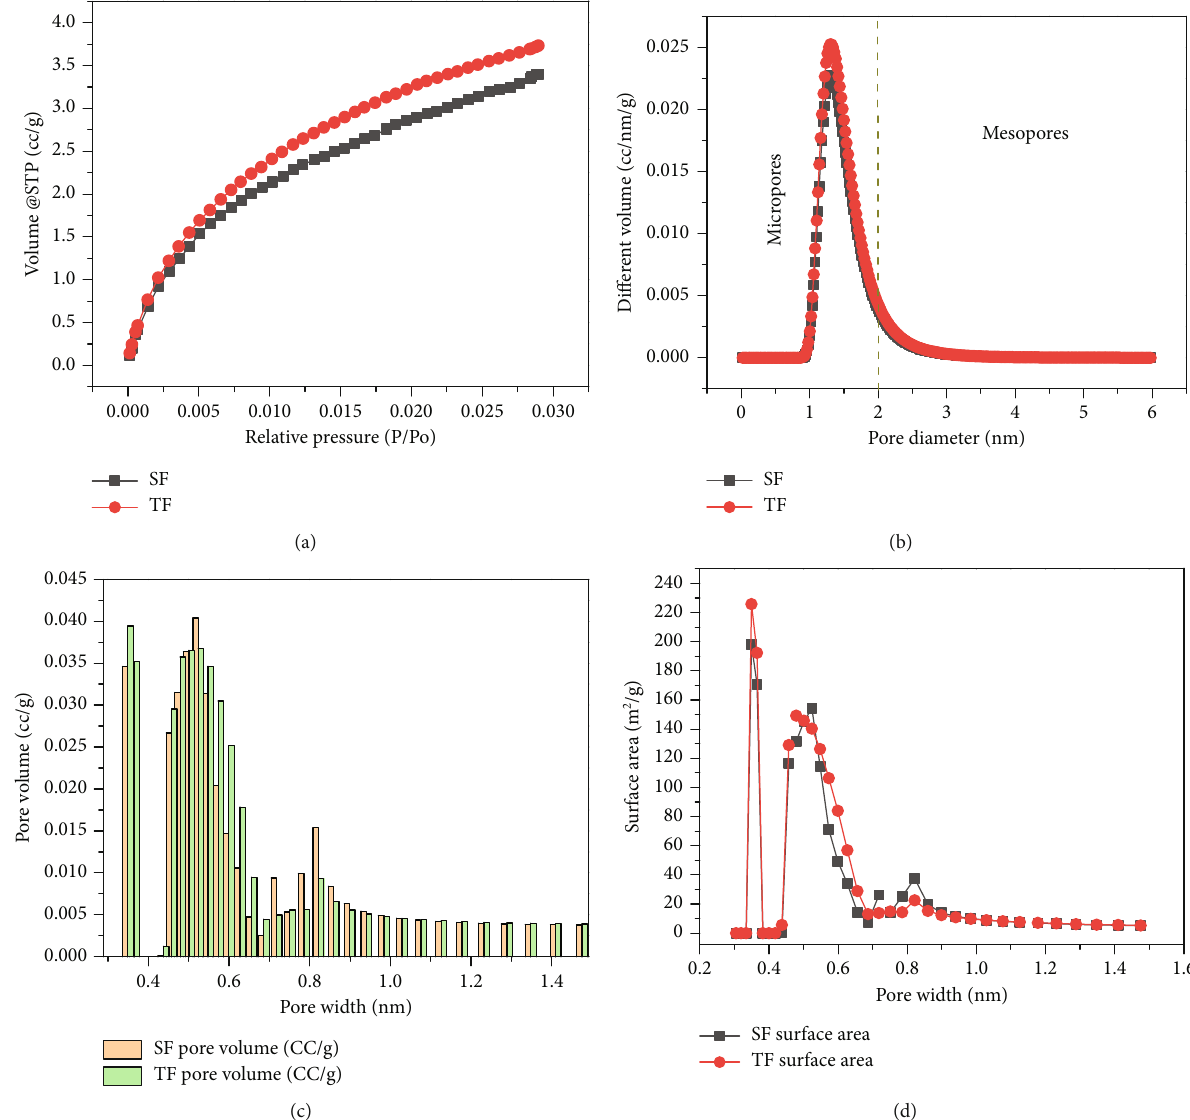
Figure 6: The description of micropore parameters in the Shanxi Formation and Taiyuan Formation in the Ordos Basin. (a) CO isothermal curves. (b) Micropore distribution in the SF and TF. (c, d) Micropore volume and surface area in the Shanxi Formation and Taiyuan